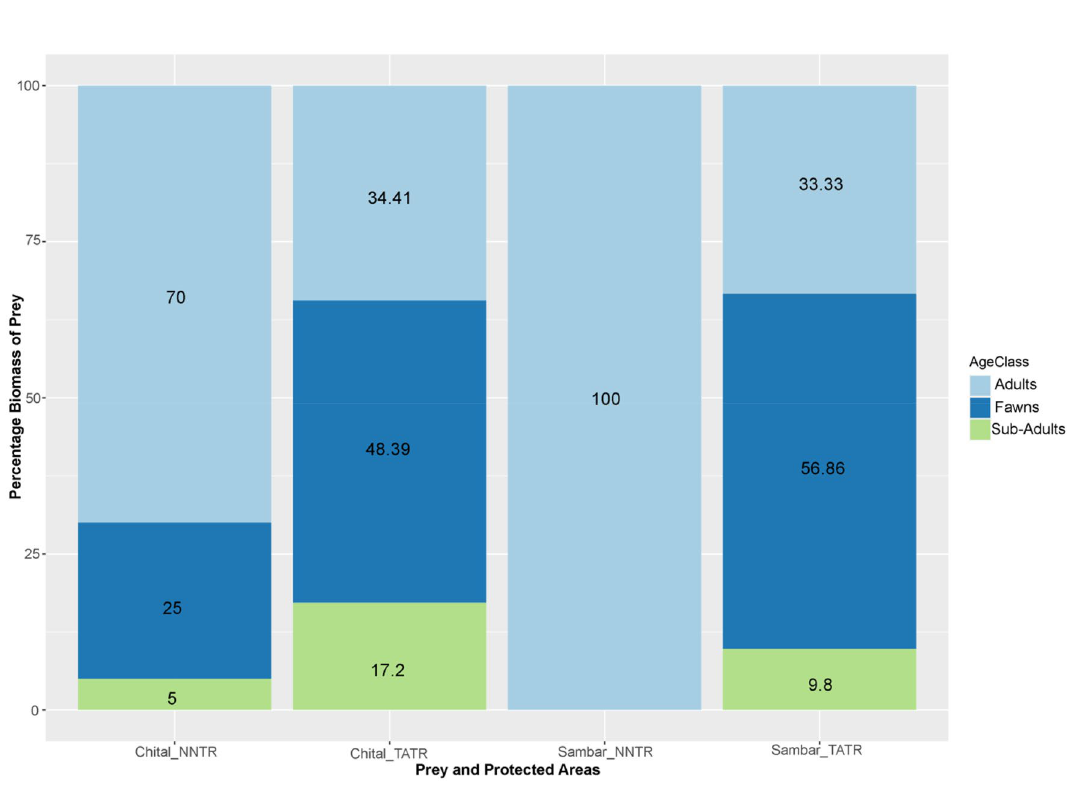
Figure 4. Proportion of age classes (Fawns, Sub-Adults and Adults) of chital and sambar found from the dhole kills in TATR and NNTR. Figure generated using the package “ggplot2” in R studio R Core Team (2019). R: